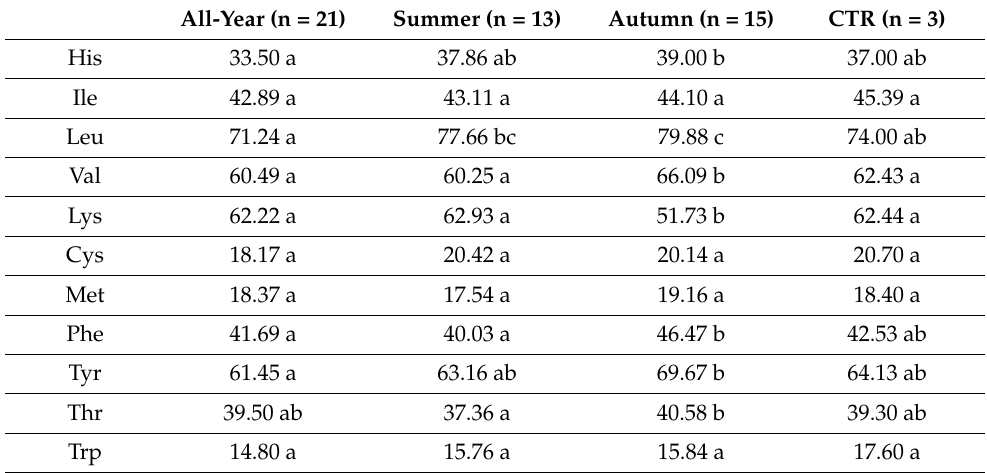
Table 2. Mean values (expressed as mg/g protein) for essential and semi-essential amino acids of BSF prepupae that had been reared on the different groups of substrates. All-Year (n = 21) Summer (n = 13) Autumn (n = 15) CTR (n = 3)